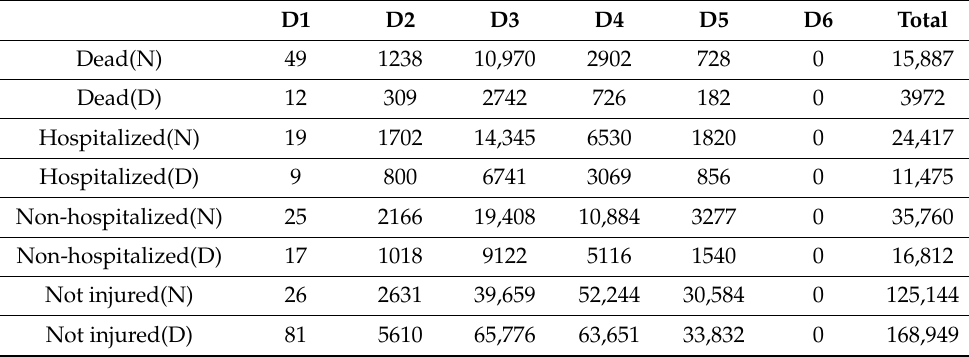
Table 21. Number of casualties in the 1780 earthquake in District 2 of Tabriz.